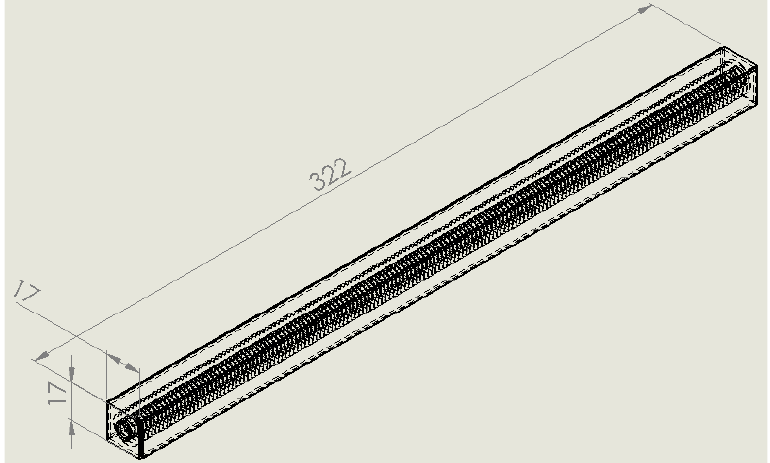
Figure 11. Dimensioned assembly drawing of the CFD study model.